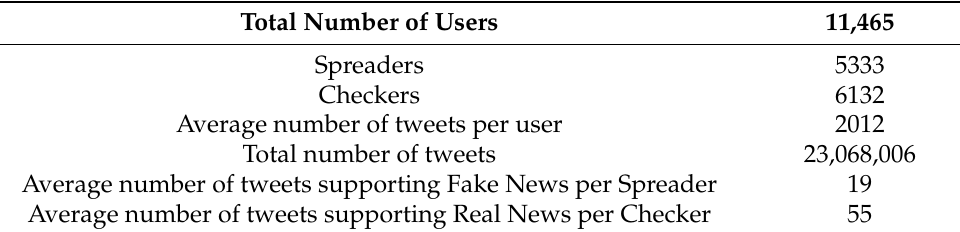
Figure 2. Pipeline to label each user as a spreader or a checker. Table 2. The CoAID extended dataset statistics.